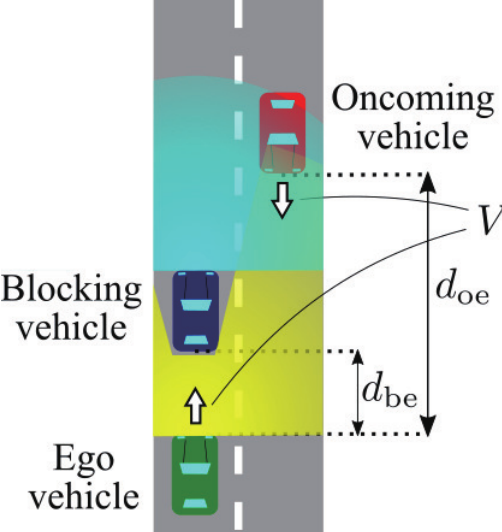
Figure 2. Illustration of the ego vehicle equipped with a 3D LiDAR sensor trying to execute overtak- ing. The yellow region is the sensing region of the ego vehicle’s LiDAR